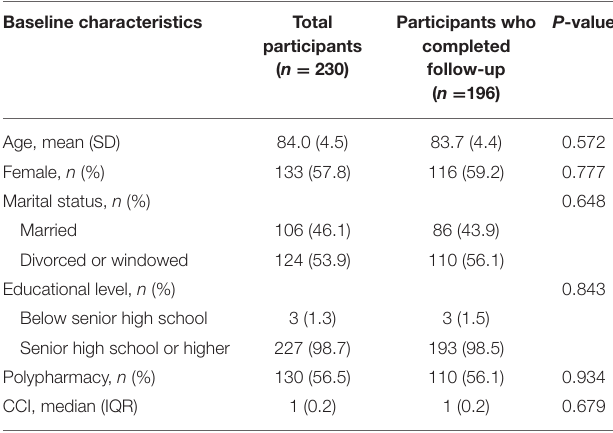
TABLE 1 | Comparison of baseline characteristics between total sample and participants who completed follow-up in a Beijing elderly